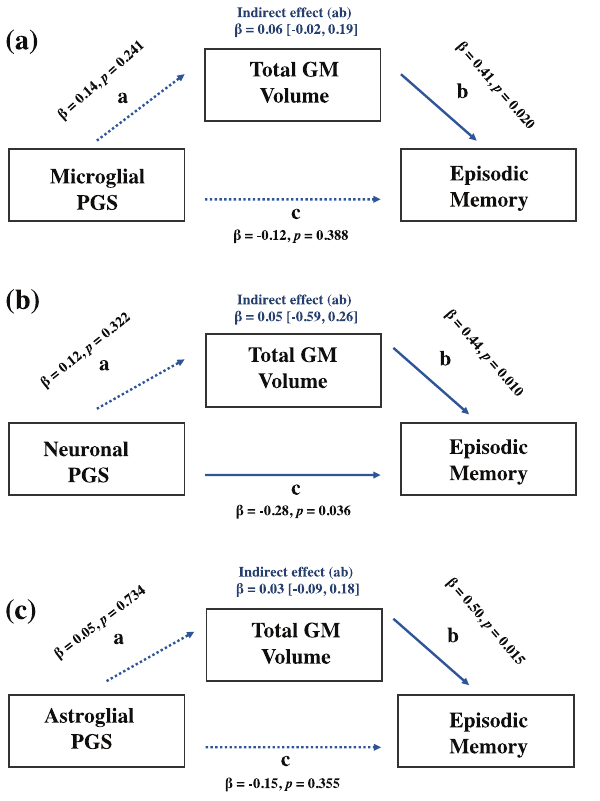
Fig. 3 Mediation results of polygenic score associations in the UK Biobank sample. Values are standardised estimates; dashed paths are nonsigni fi cant. Indirect estimates are reported (a*b). a The effect of the microglial polygenic score on general cognitive ability as mediated via grey matter volume. b The effect of the neuronal polygenic score on general cognitive ability as mediated via grey matter volume. c The effect of the astroglial polygenic score on general cognitive as mediated via grey matter